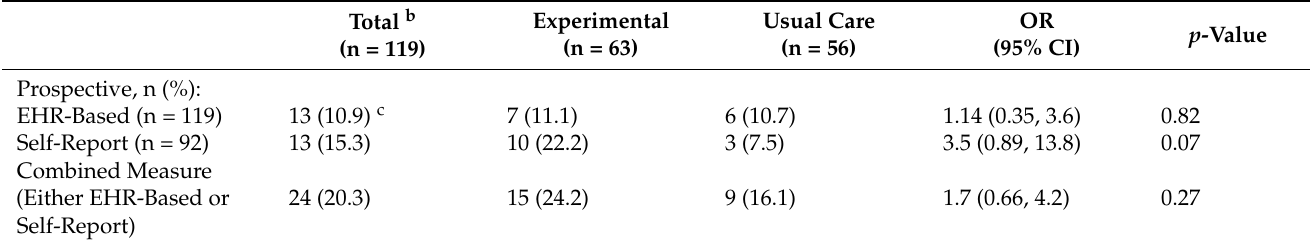
Table 2. SSTI recurrence in Index Patients at six-month follow-up a